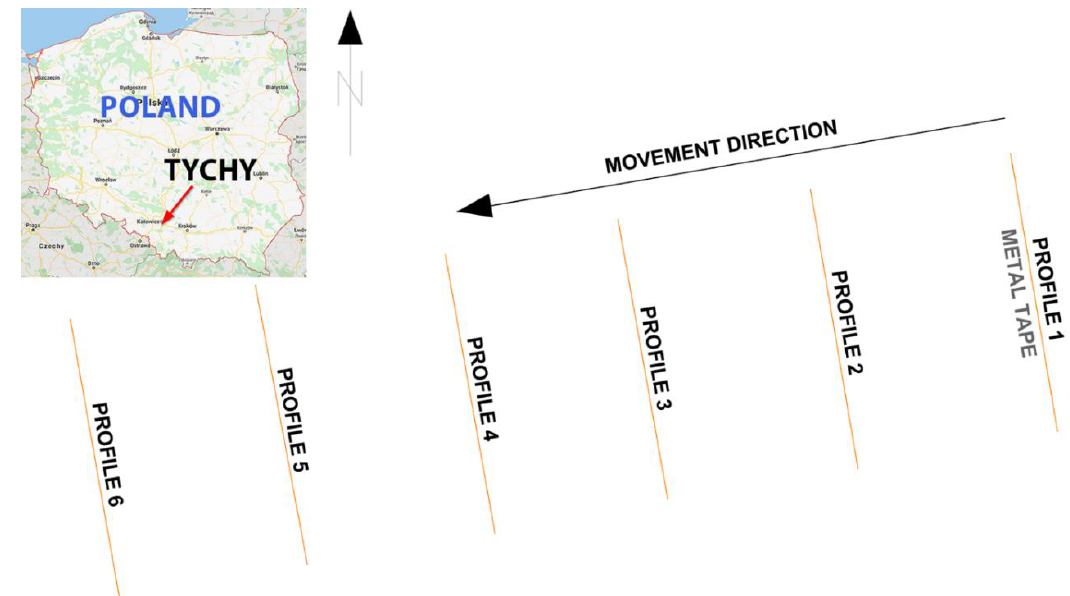
Figure 6. Location and scheme of the test basis.